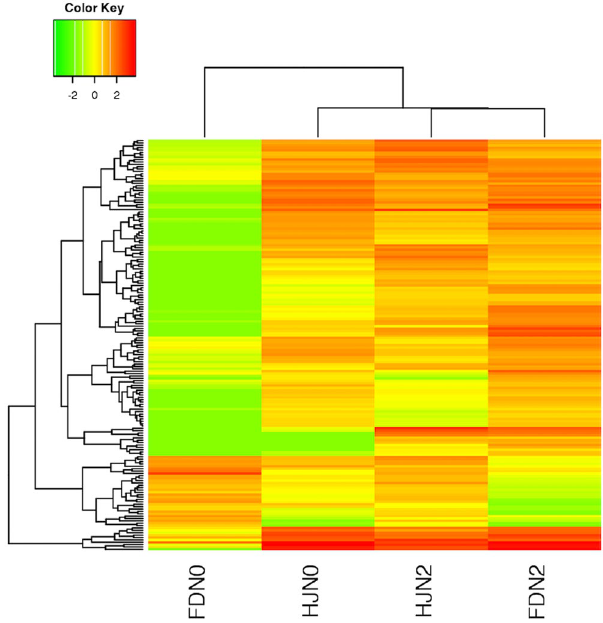
Figure 3. The expression patterns of shared differentially expressed genes in the roots of Camellia . The heatmap represents the relative expression levels of 196 common DEGs in the roots of the Camellia varieties HJ and FD. Expression levels were determined in FPKM using RNA-seq and were log2-transformed. The tree diagram represents the similarity between the four samples or between the common genes. “HJN0” and “FDN0” represent C . sinensis HJ/FD treated with 0 g of (NH 4 ) 2 SO 4 (the control), and “HJN2” “FDN2” represent C . sinensis HJ/FD treated with 22 g (NH 4 ) 2 SO 4 .